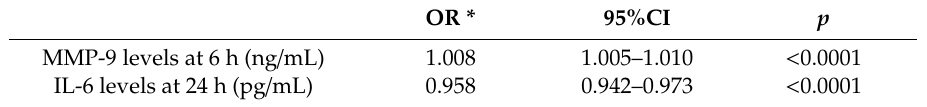
Table 5. Logistic regression model for the levels of biomarkers related to e ff ective reperfusion. OR * 95%CI p MMP-9 levels at 6 h (ng / mL)